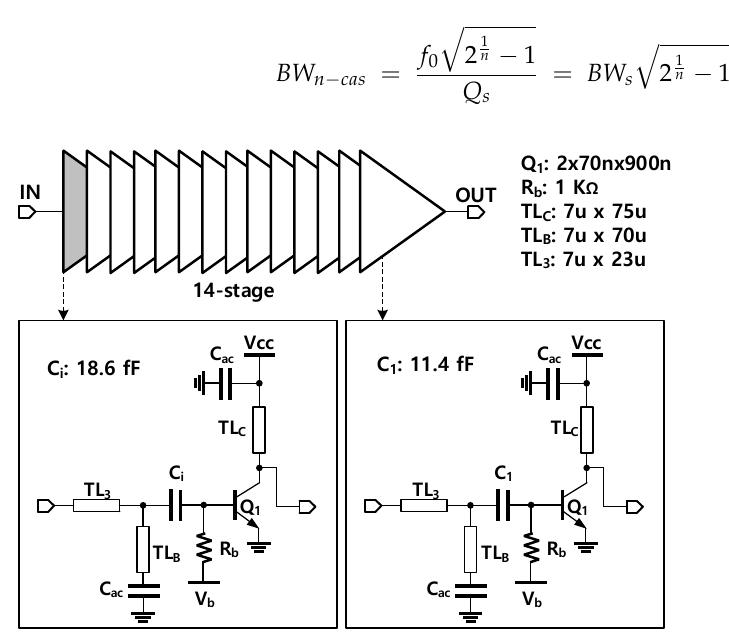
Figure 1. Schematic of the 280 GHz